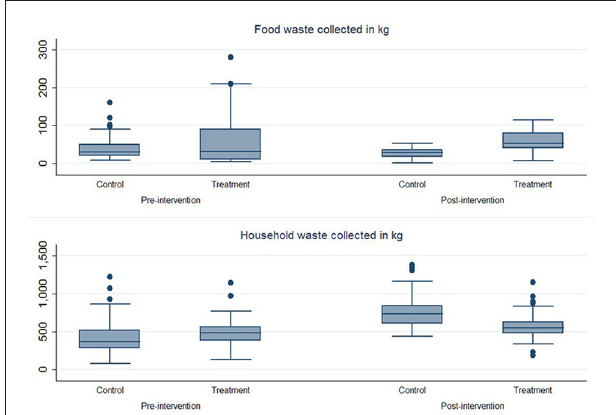
FIGURE 4 | Box plots of the amount of food waste collected (upper) and household waste collected (lower) in the control group and the treatment group pre- and